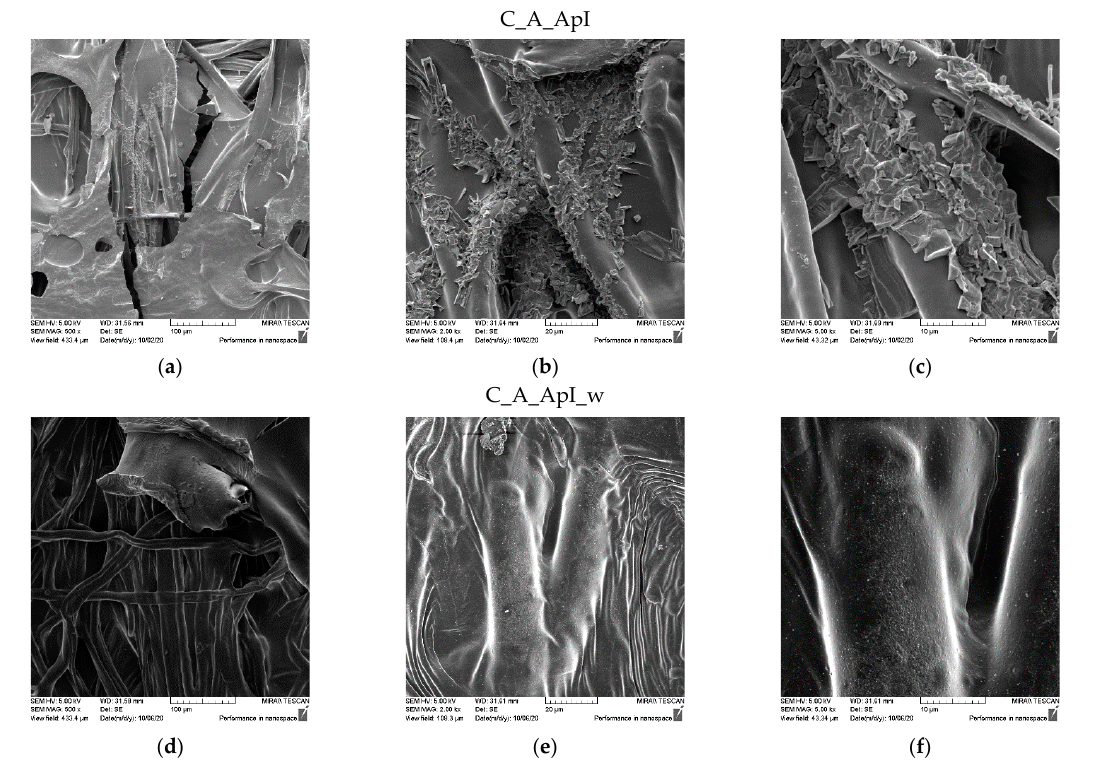
Figure 4. SEM micrographs of satin weave fabric samples treated with Bath I before (C_A_ApI)